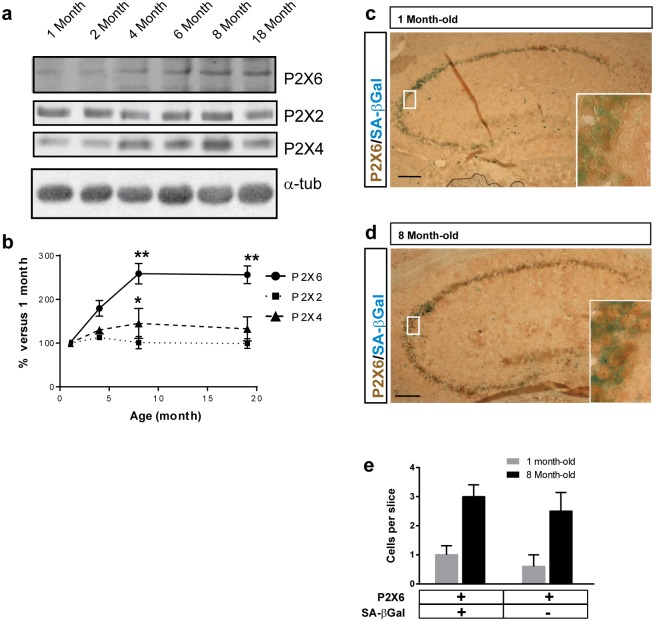
Age-dependent expression of P2X6 is not related with senescence.(a) Western blot analysis for expression of P2X2, P2X4 and P2X6 proteins in mice (from 1 to 18 month-old) (b) Graph represent P2X6, P2X2 and P2X4 levels relative to 1 month-old mice. Levels for P2X6 expression is on average 2.58±0.14-fold higher, P2X4 subunit only increases 1.45±0.19-fold at 8 month, and P2X2 level remains invariable (mean±s.e.m, n = 7 mice, * P<0.05, ** P<0.01 One-way ANOVA with Dunnett post-hoc test using 1 month-old mice data as control). (c,d) Immunohistochemical analysis of brain section from 1 (c) and 8 months-old (d) mice. Immunohistochemistry against P2X6 subunits (brown) and detection of senescence-associated β-galactosidase activity (SA-βGal, blue) in hippocampal slices. Scale bar 200 μm. Insets depict enlarged views (40X magnification) of delimited area. (e) Quantification of both P2X6 and/or SA-βGal positive cells in hippocampal slices from 1 month-old and 8 month-old mice (mean±s.e.m., n = 3 mice, P = 0.72 unpaired Student’s t-test between same age).